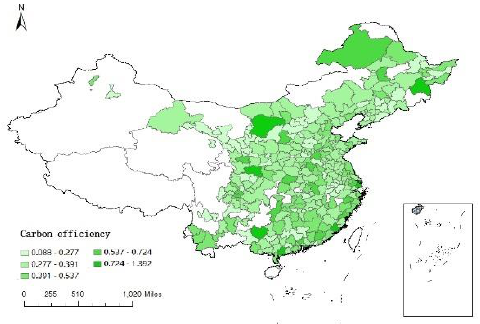
Figure 5. Carbon efficiency distribution of cities in China